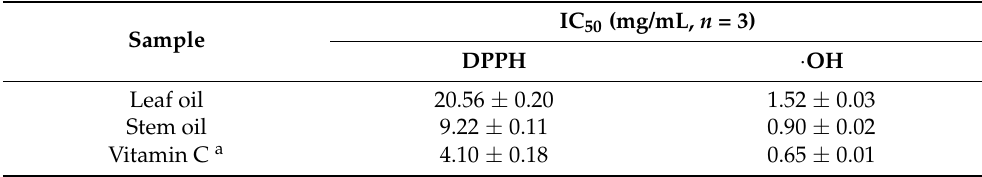
Table 2. Antioxidant capacities of leaf and stem oils in F. japonicum